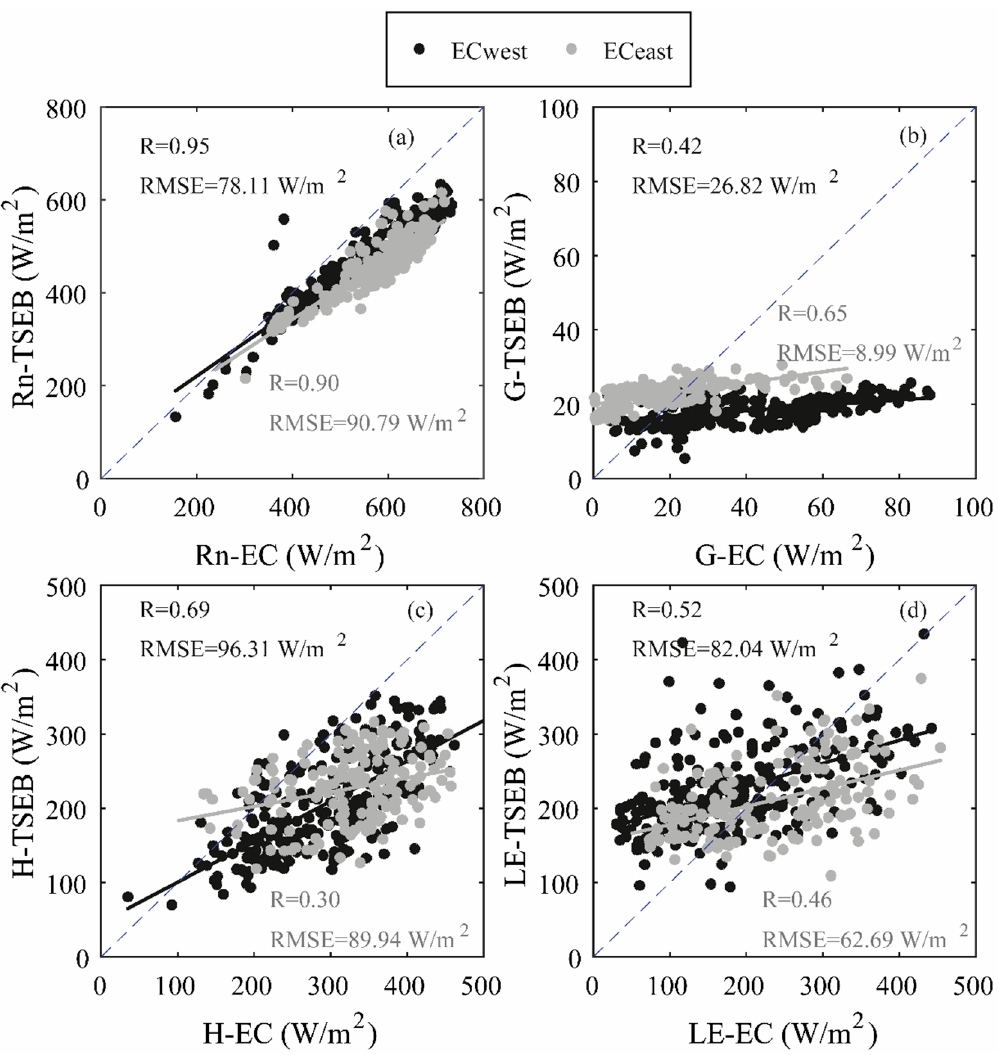
Figure 9. Same as Figure 8 but for MODIS products.